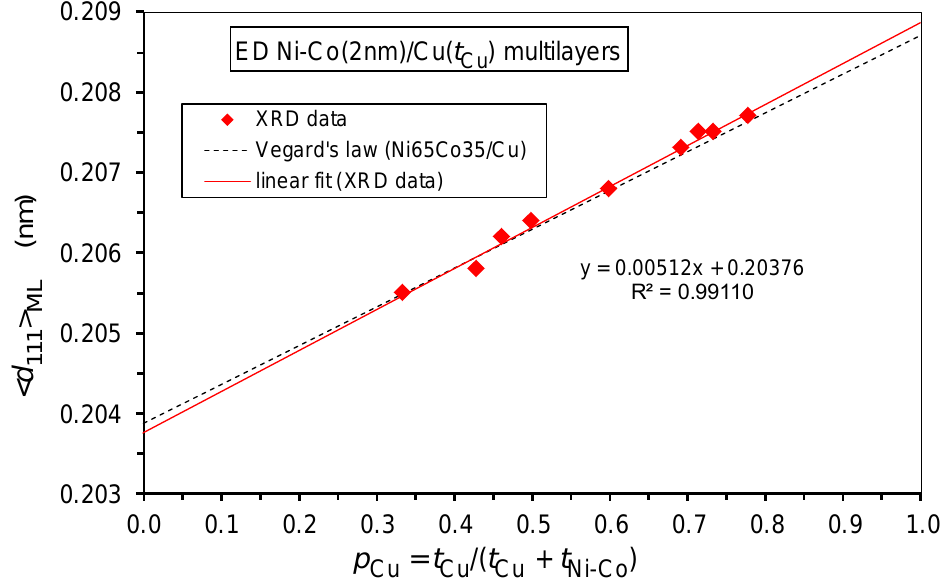
Figure 7. Average lattice spacing < d 111 > ML perpendicular to the multilayer plane as determined from the position of the (111) Bragg reflection vs. fractional thickness p Cu of the non-magnetic (Cu) layer for the present Ni 65 Co 35 /Cu multilayers (full diamond symbols). The solid line is a linear fit to the data. The dashed line corresponds to the “multilayer” Vegard’s law for these multilayers [45,67].